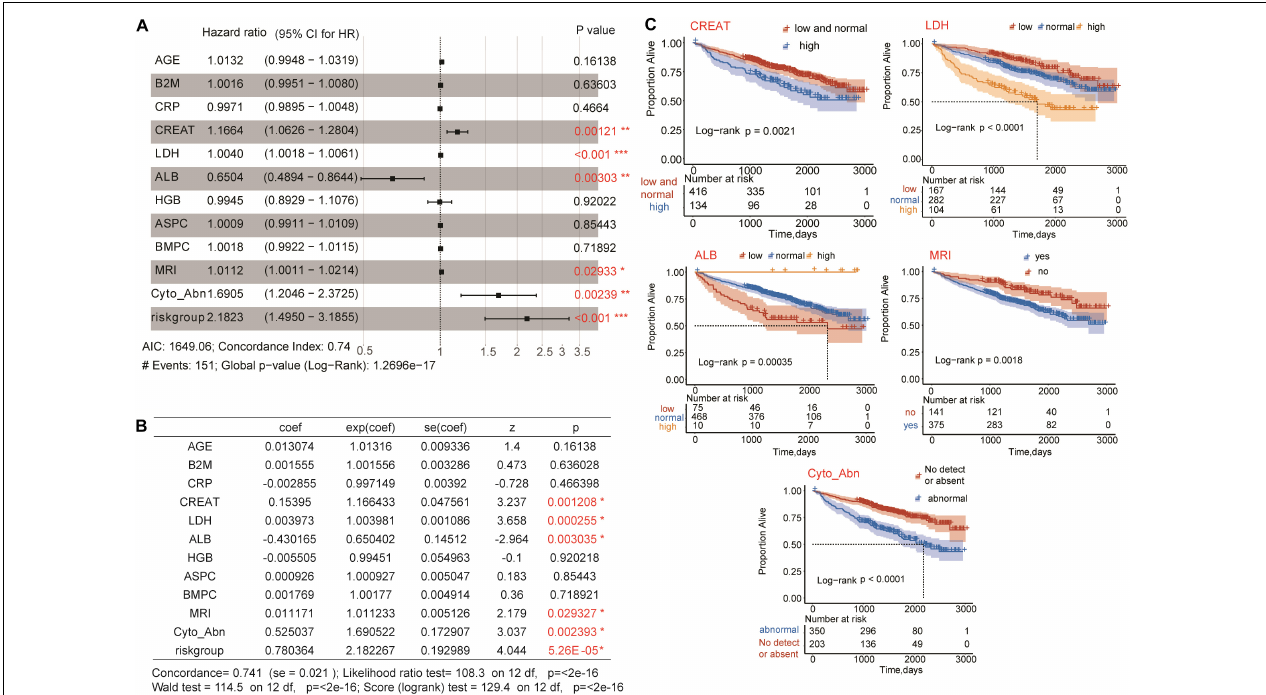
FIGURE 5 | Multivariate Cox regression analysis of five-gene risk group and clinical risk indicators. (A,B) CREAT, LDH, ALB, MRI, Cyto_Abn, and five-gene risk group were significantly associated with the overall survival of multiple myeloma patients (* p < 0.05, ** p < 0.01, and *** p < 0.001). (C) Kaplan-Meier survival plots of